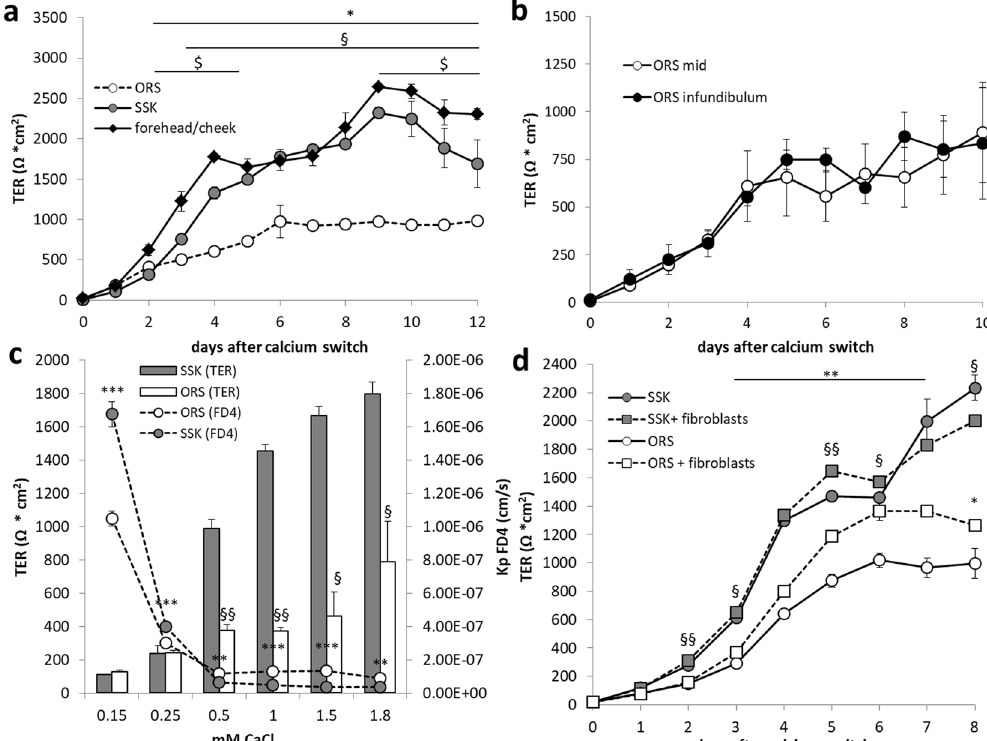
Figure 4. Barrier function of cultured HF keratinocytes. ( a ) Representative time dependent TER curve of keratinocyte cultures isolated from ORS, SSK, and forehead/cheek under submerged culture conditions. Means ± SD; triplicate wells n = 3 different donors; significant differences are indicated with * (between ORS and forehead/cheek) and § (between ORS and SSK) and $ (SSK and forehead/cheek), respectively. ( b ) Time dependent TER curve of ORS keratinocytes isolated from infundibulum (black circles), and mid segment (open circles) of HFs (means ± SEM; triplicate wells n = 3 different donors). ( c ) Representative TER diagram (column plot) in an overlay with the corresponding permeation coefficients for FD4 (line plot) of ORS and SSK keratinocytes at different calcium concentrations at day 8. Means ± SD for line plot or + SD for columns; triplicate wells, n = 4 different donors; significant differences are indicated by § for TER and by * for FD4 permeation. ( d ) Representative time dependent TER curve of ORS and SSK keratinocytes cultured in presence or absence of fibroblasts (means ± SD; triplicate wells, n = 3 different donors; significant differences between keratinocytes grown in presence and absence of fibroblasts are indicated by § for SSK and by * for ORS. Statistical test for all: